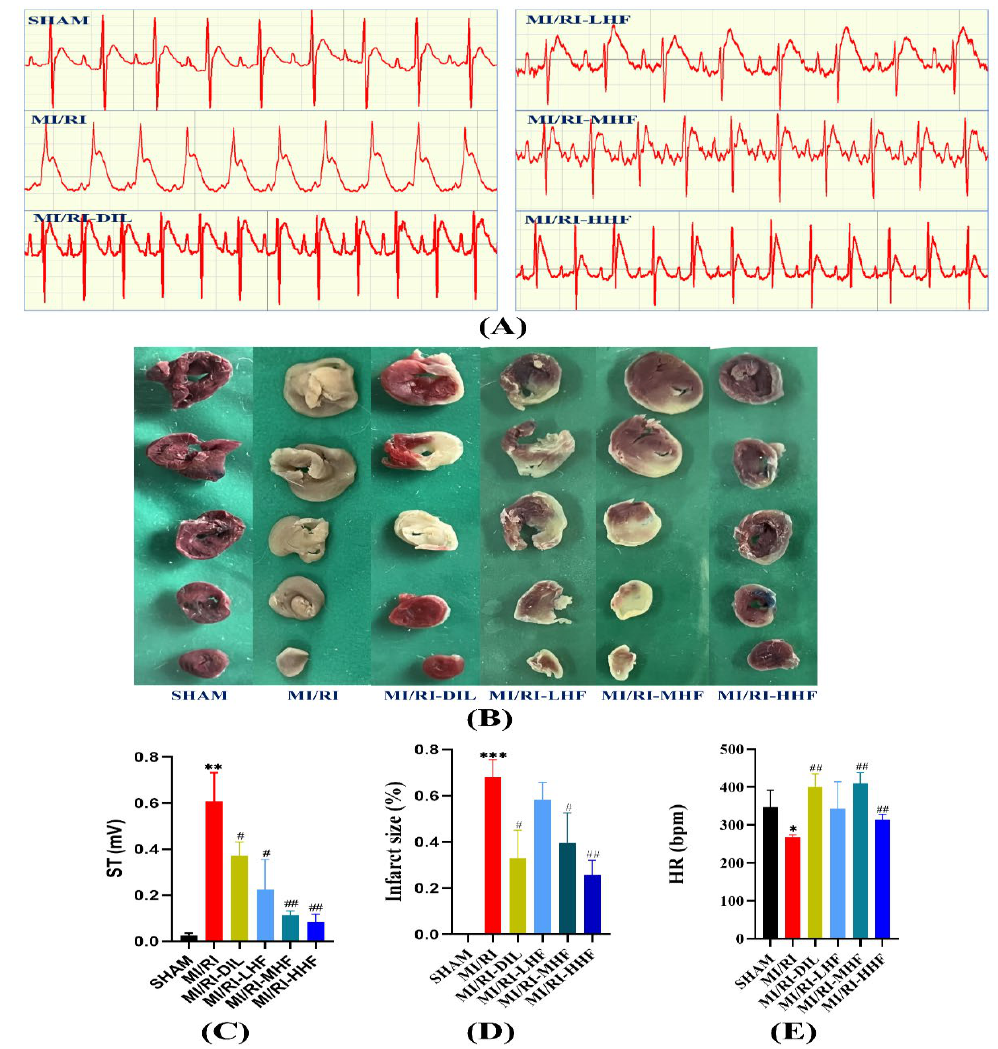
Figure 2. Effects of HF on the electrocardiograph (ECG) parameters and infarct size. ( A ) Representative ECGs of each group. ( B ) Representative images from each group in the TTC staining ( n = 3). ( C ) The elevation of the ST segment from each group on the electrocardiograph ( n = 3). ( D ) Quantitative analysis of the myocardial infarction area in each group ( n = 3). € Heart rate from each group ( n = 3). Results were expressed as mean ± SD. * p < 0.05, ** p < 0.01, *** p < 0.001 vs. SHAM group. # p < 0.05, ## p < 0.01 vs. MI/RI